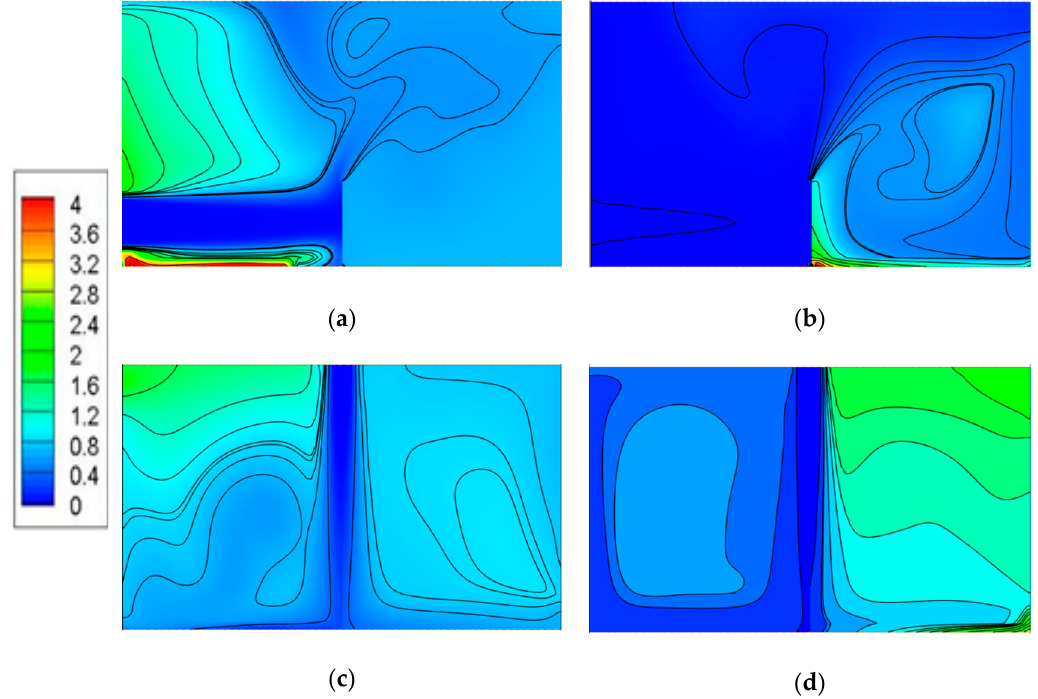
Figure 9. CO 2 concentration cloud map of Y = 1.5 m section: ( a ) Case 1, ( b ) case 2, ( c ) case 3, ( d ) case 4.